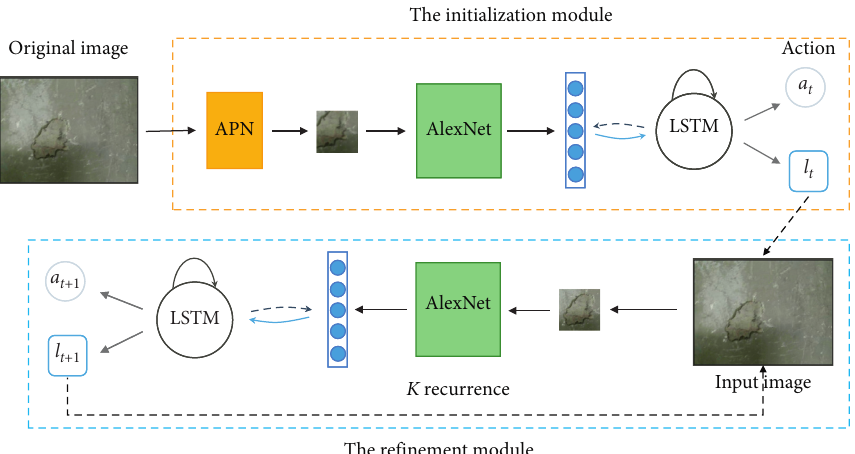
Figure 4: The detection and classification architecture of the wall defect. The initialization module is used to calculate rough center coordinates of detection, and the refinement module is used to refine detection and classification results with K recurrence iterations.